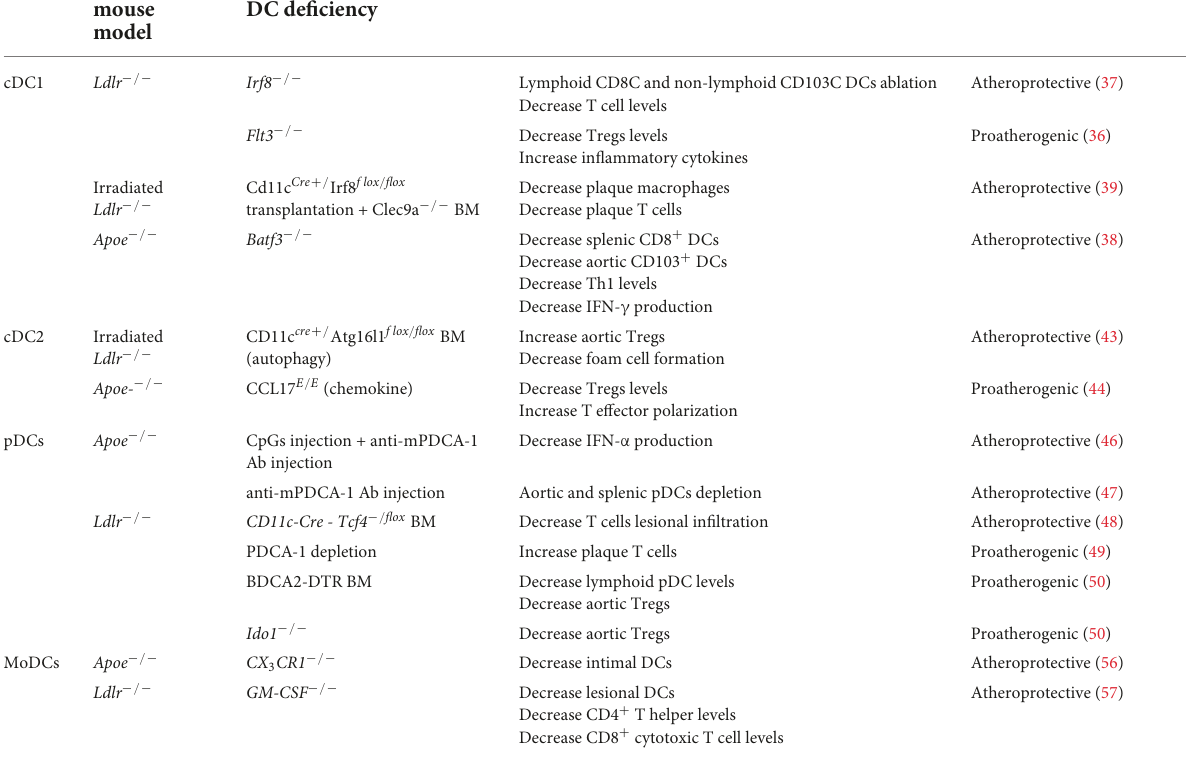
TABLE 2 Overview of studies on DC subsets and atherosclerosis-related phenotype. Atherosclerosis